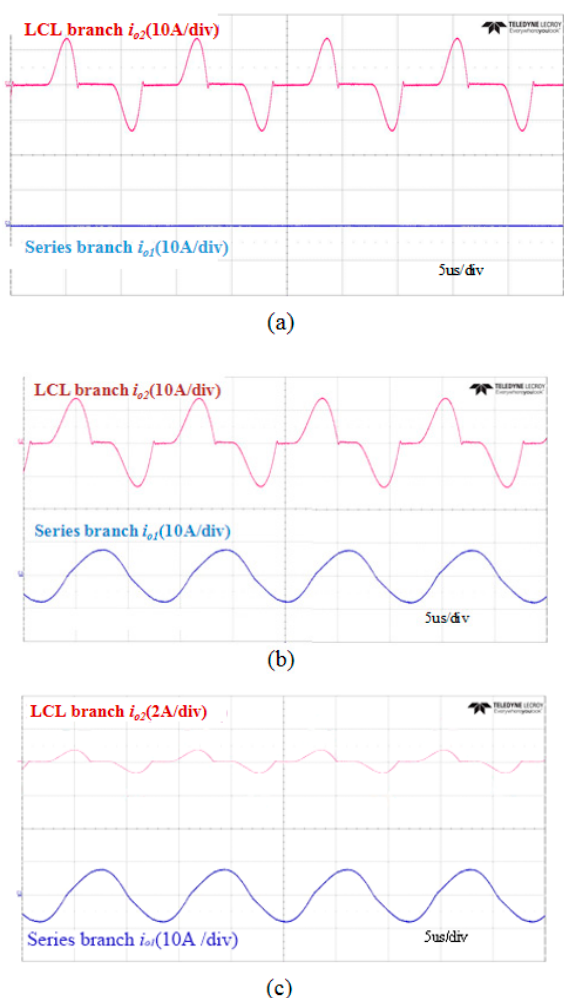
Figure 22. Current distribution: ( a ) constant voltage mode; ( b ) transient process; ( c ) constant current mode.